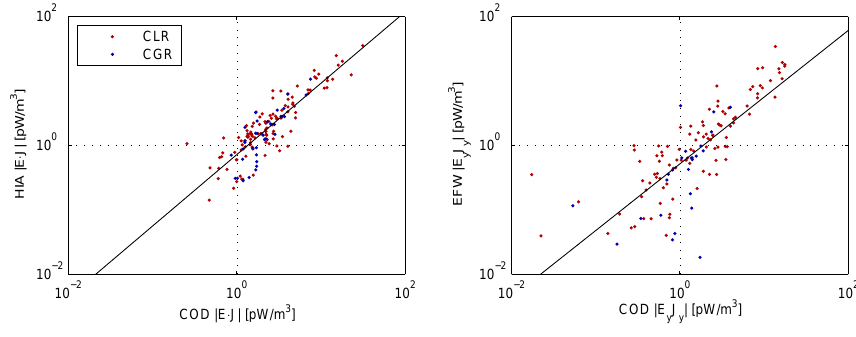
Fig. 3. Cross-check of the power density obtained for the selected ECRs by using electric field estimates from CODIF, HIA and EFW (only the DSI y-component is used for cross-checking with EFW). Straight lines (on the logarithmic scale) have been fitted to the data. Left: | E · J | for HIA versus CODIF. Right: DSI | E y J y | from EFW versus CODIF. Red and blue correspond to CLRs and CGRs, respectively. Only the absolute value of the power density is plotted. Note that the same scalings of the axes are used. Correlation coefficients for the non-log data are 0.92 for the left plot and 0.86 for the right plot. We see that the correlation between the instruments is generally good.